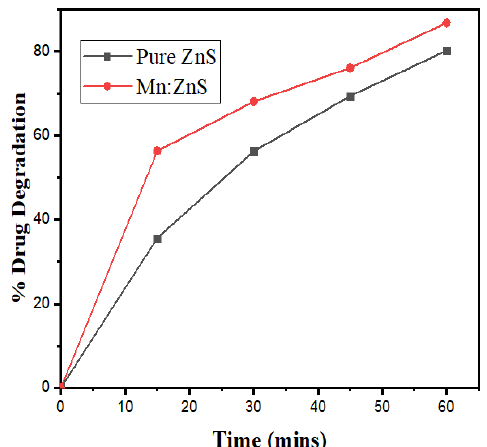
ff ect of Mn 2 + doping on the percentage degradation of drug NOFX under optimal conditions Figure 15. Effect of Mn 2+ doping on the percentage degradation of drug NOFX under optimal Figure 15. E